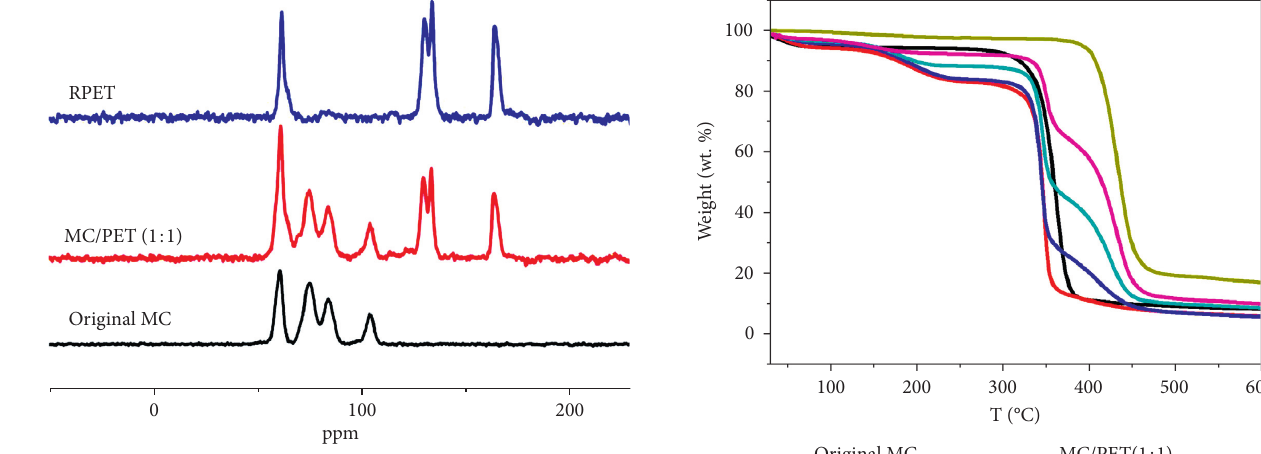
Figure 2: Solid-state 13 C NMR spectra of MC, MC/PET (1:1) film, and PET.